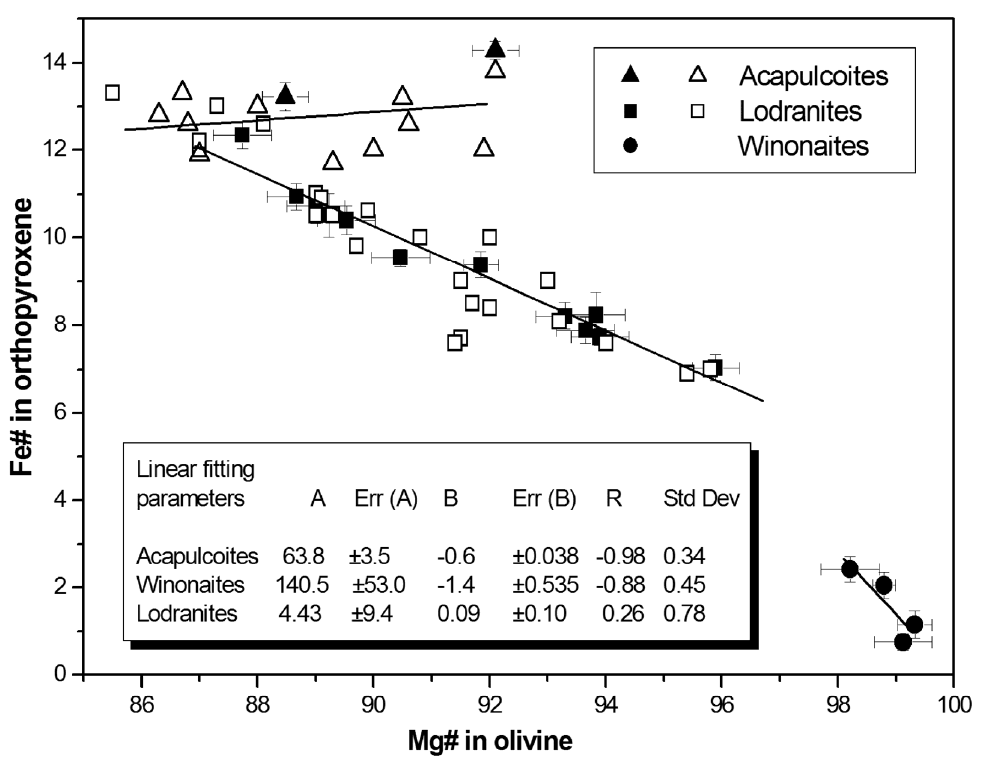
Figure 7. Reduction degree diagram (Fe# in orthopyroxene as a function of the Mg# in olivine) including the linear fitting of the data. Open symbols are literature data [1]. The inset shows the linear fitting parameters for each meteorite